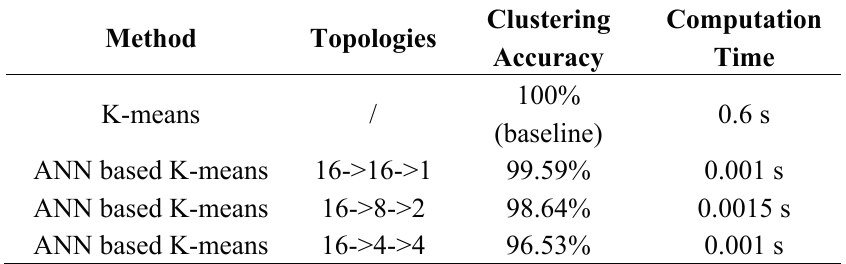
Table 1. Performance comparison for feature clustering.